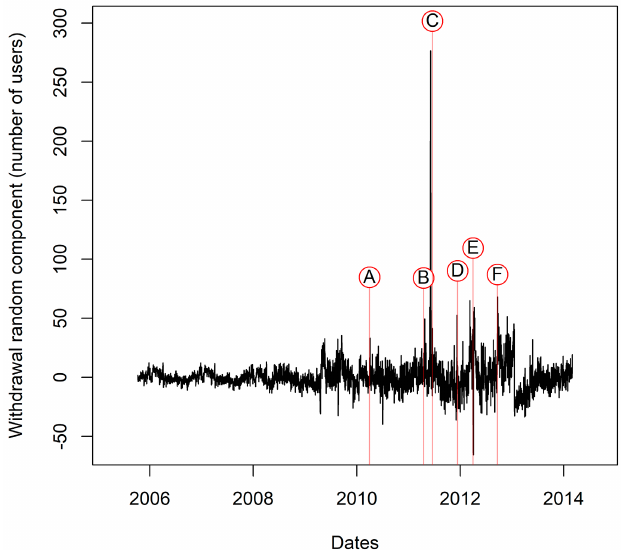
Figure 6. Random components of withdrawals from the OSM project and largest outstanding events (A–F). The sharp drop seen after the last event (F) is an artefact of the 598-day threshold assigned to new contributors, and the time at which the history dump file was created.